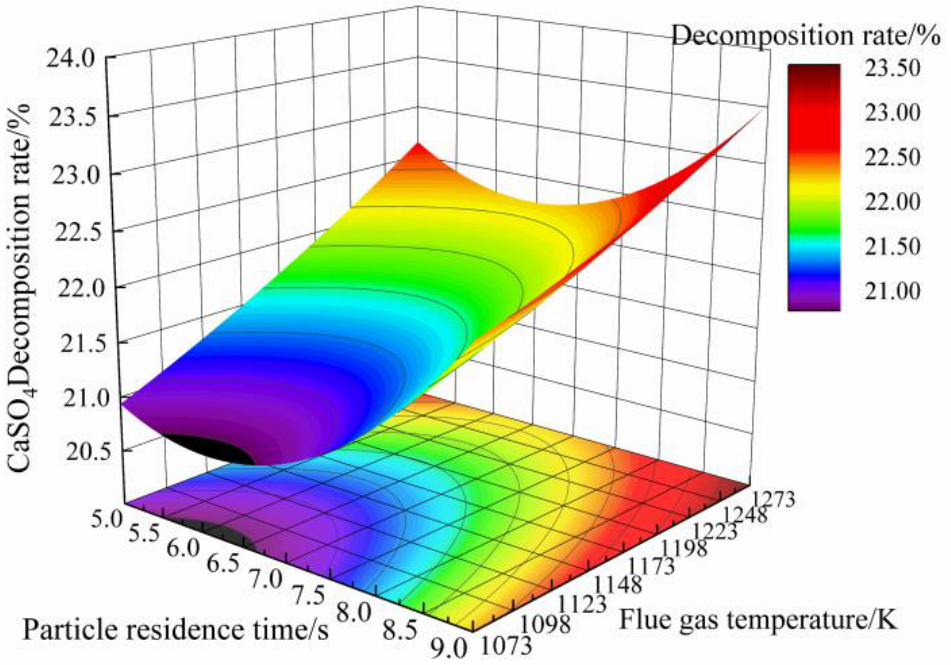
Figure 21. Effect of particle residence time and flue gas temperature on CaSO 4 decomposition rate.